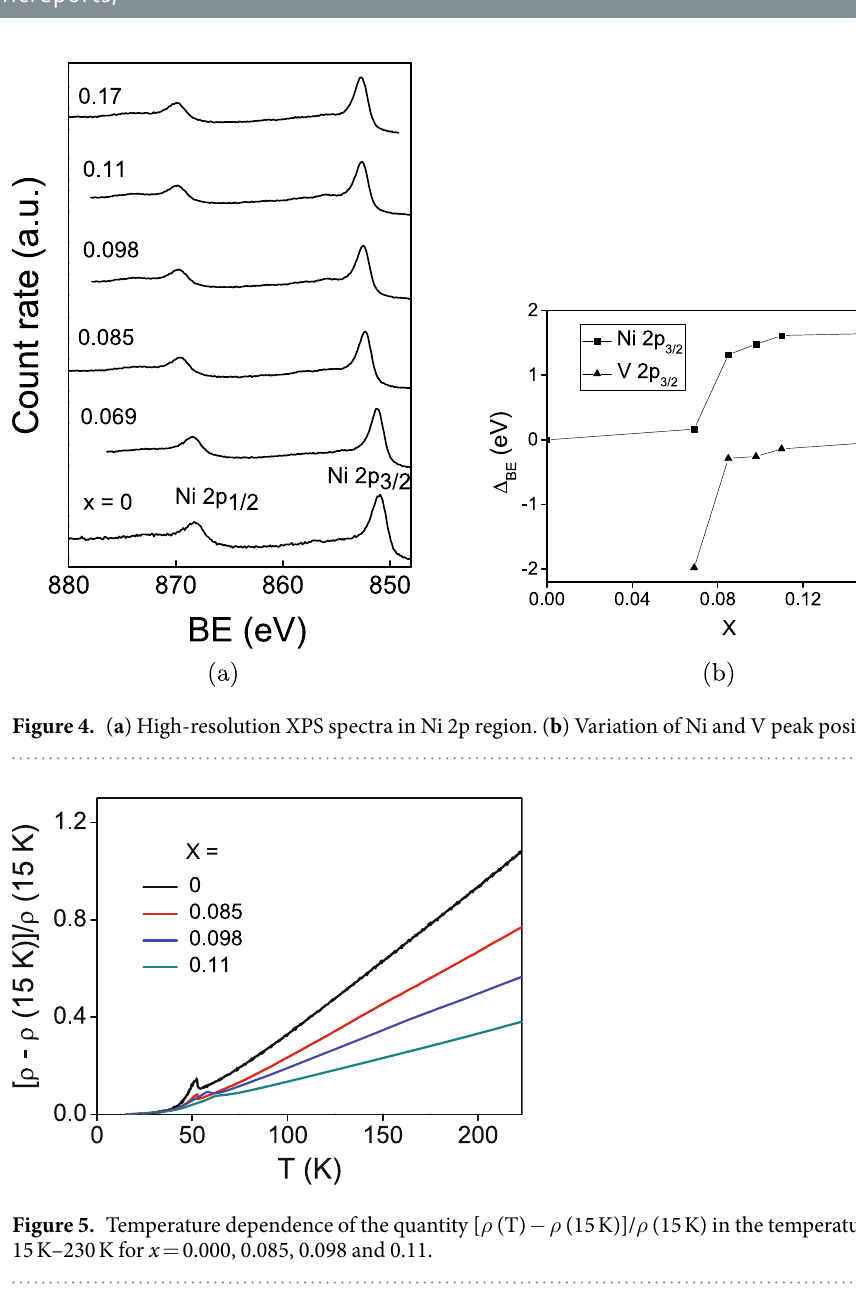
are suitably shifted to coincide roughly at the same point at 300 K. The occurrence of ZFC-FC splitting in all the cases is characteristic of magnetic nanoparticles as discussed above 14, 15 , and indicates that all the nanoparticles (with V concentration as high as 17%) have a major magnetic component. This is in agreement with the HRTEM observation of particle agglomeration as pointed out earlier. There is a broad peak in the ZFC curve for each sample and the ZFC-FC splitting takes place at a temperature higher than the (broad) peak value. This is indic- ative of a distribution of particle size in every sample, as has been discussed earlier 14, 15 , and is also evident from the FESEM analyses (Fig. S1). Figure 6(a) marks the tentative average positions of T B (ranging between 200 to 250 K) for each sample. Using the relation T B ≈ KV /(30 k B ) mentioned above and taking K = 5 × 10 4 erg cm − 1 for Ni 24 , the average of the particle sizes for different samples would range between 17 to 20 nm, which is more or less consistent with the FESEM results and is suggestive of single-domain nature of the NP’s in all the cases. The near saturation of all the FC curves below T B , until the curves rises again at even lower temperatures, suggests that the NP ensembles are in a BFM state below T B and in an SPM state above it, as discussed in the introduction. Another feature of the M − T curves which is apparent is the low- T upturn below ~20 − 30 K in both FC and ZFC magnetizations of all the samples. This rise would primarily mean the presence of an extra FM or PM-like phase in the NP. In order to determine what exactly the magnetic nature of this phase for a particular x is, we first extrapolate the plateau region of the corresponding FC curve down to the lowest temperature measured, and then subtract the extrapolation from the measured FC curve. Figure S4 in the Supplementary information shows the extrapolations, while Fig. 6(b) shows the subtracted curves representing the additional magnetization component